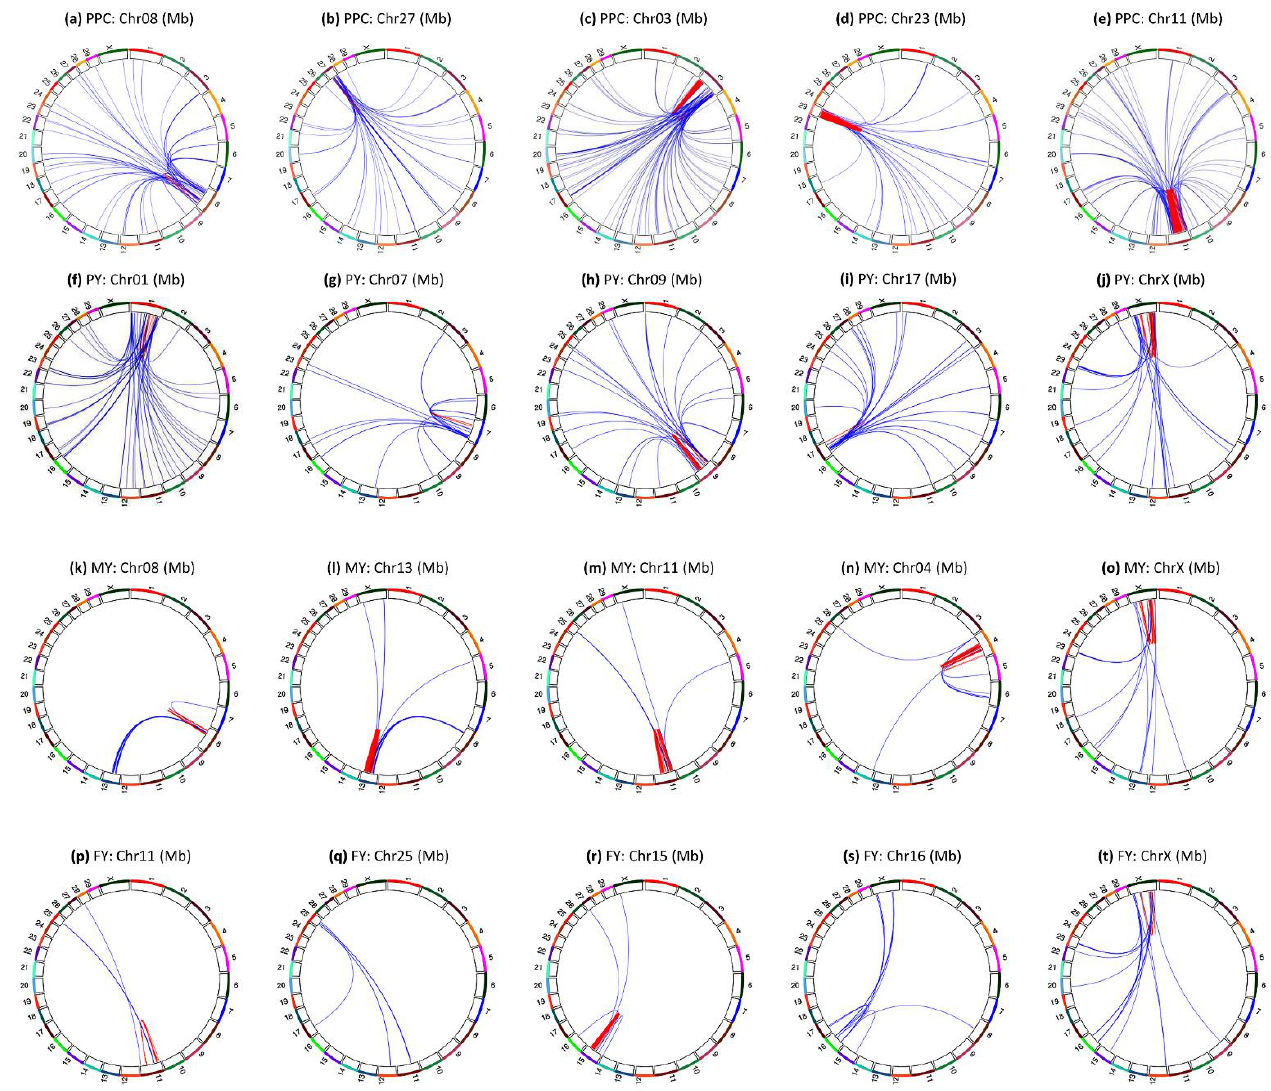
Figure 10. Examples of inter-chromosome epistasis effects with log10(1/p) ≥ 12 for protein percentage and the three yield traits. Each number on the outer circle is the chromosome number, red color represents intra-chromosome epistasis effects, and blue color represents inter-chromosome epistasis effects. PPC = protein percentage. PY = protein yield. MY = milk yield. FY = fat yield. ( a )-( e ): Examples of inter-chromosome epistasis effects for protein percentage. ( f )-( j ): Examples of inter-chromosome epistasis effects for protein yield. ( k )-( o ): Examples of inter-chromosome epistasis effects for milk yield. ( p )-( t ): Examples of inter-chromosome epistasis effects for fat yield.